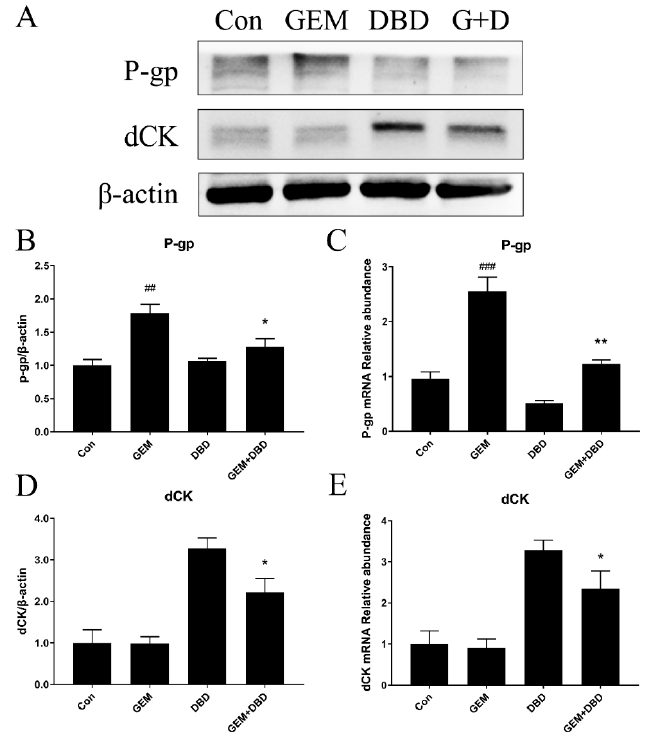
Figure 4. Expression of P-gp and dCK protein ( A , B, and D ), and mRNA ( C and E ) level in tumor tissue of LLC tumor-bearing mice. Data were expressed as mean ± SEM ( n = 10) * p < 0.05, GEM + DBD versus GEM. ** p < 0.01, GEM + DBD versus GEM. ## p < 0.01, GEM versus control (Con). ### p < 0.001, GEM versus Con.